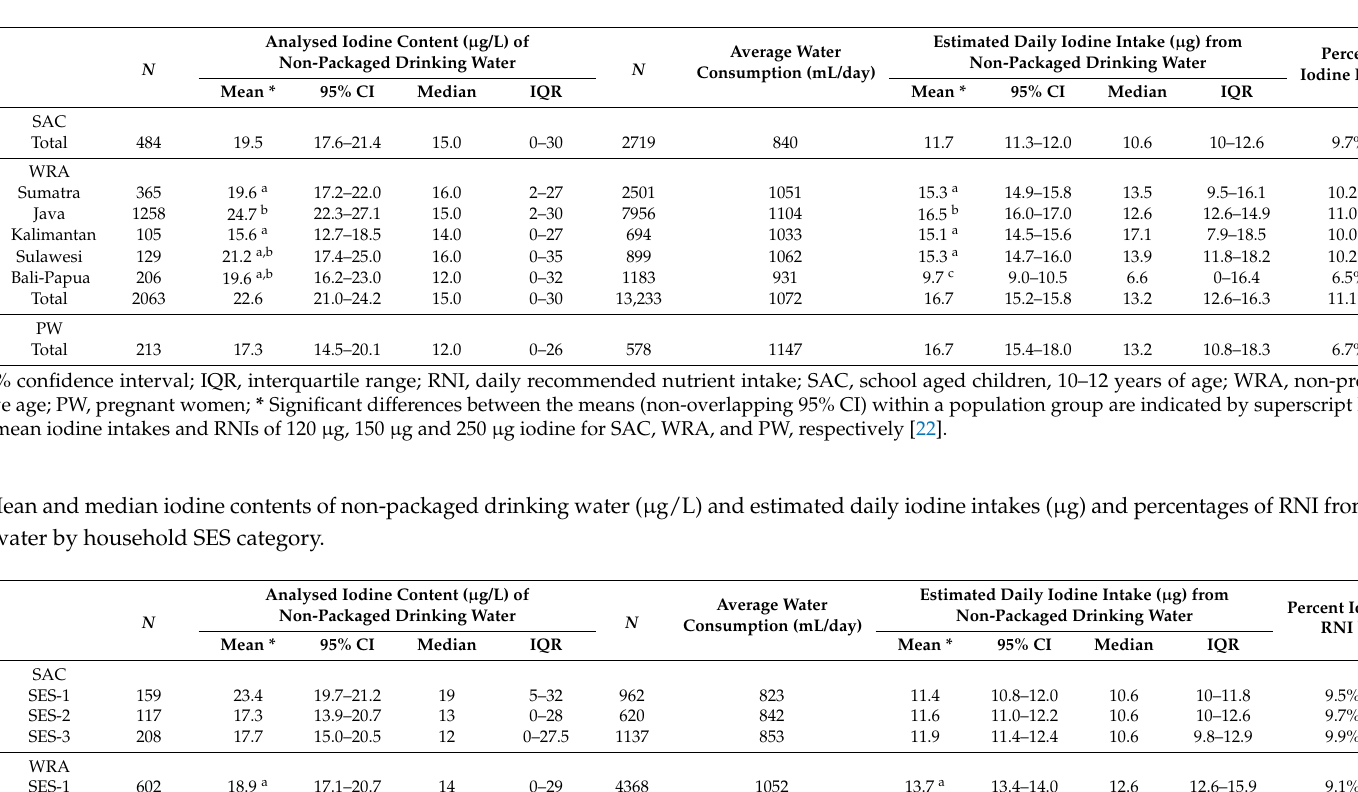
Table 5. Mean and median iodine contents of non-packaged drinking water ( µ g/L) and estimated daily iodine intakes and percentages of RNI from non-packaged drinking water by region.